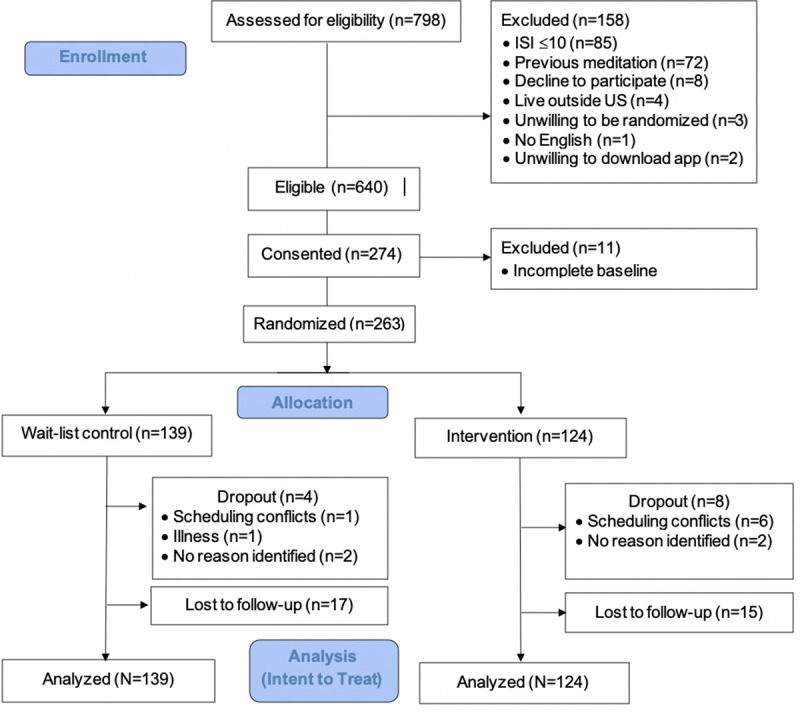
Consort diagram.